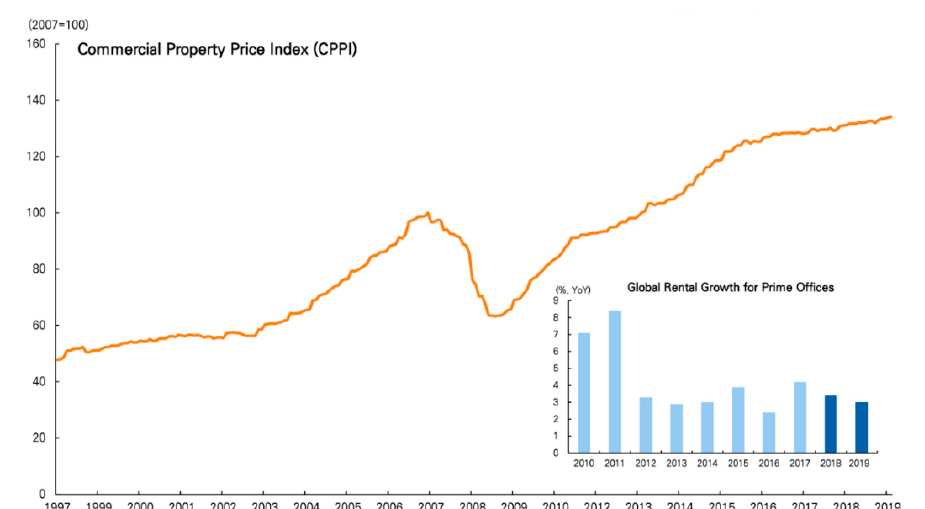
Figure 1. Global real estate index.